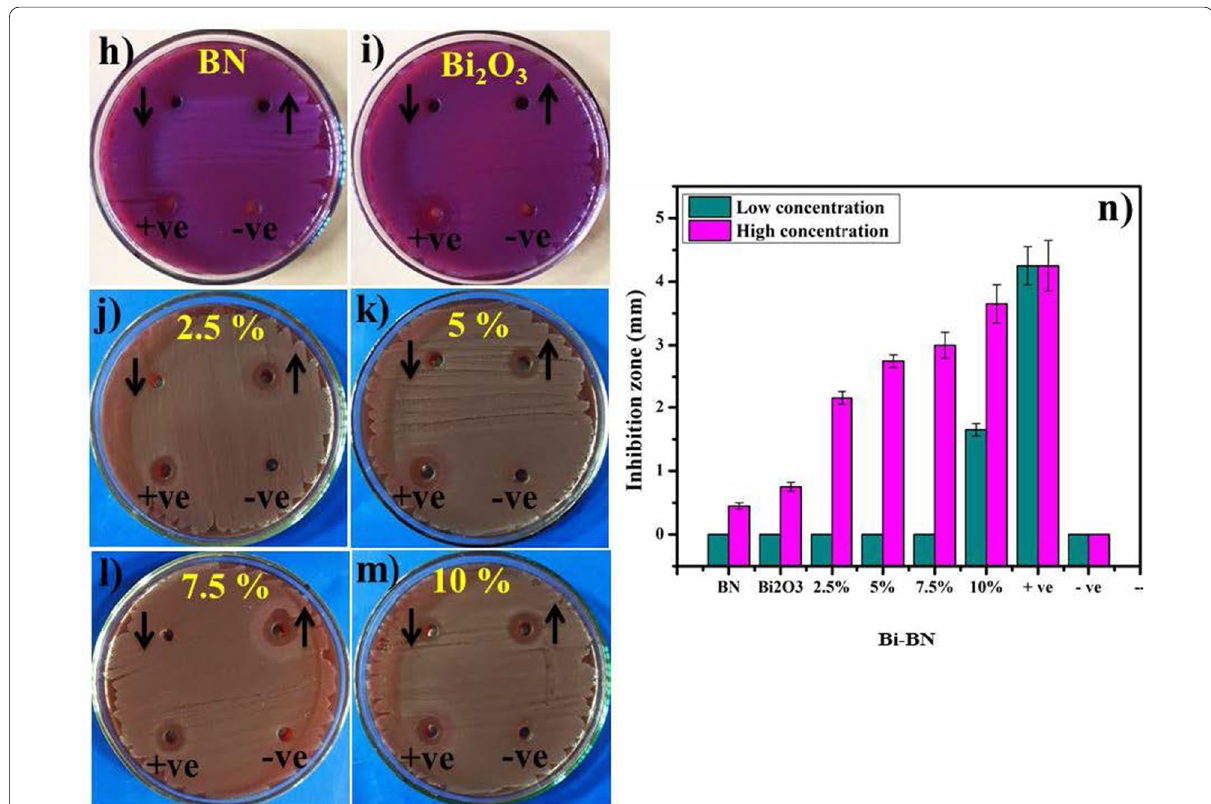
Fig. 9 h – n In‑vitro antimicrobial efficiency of BN ( h ) Bi 2 O 3 ( i ) BN nanosheets doped with various concentrations (2.5, 5, 7.5 and 10 wt%) of Bi against E. coli ( j – m ) graphical demonstration ( n